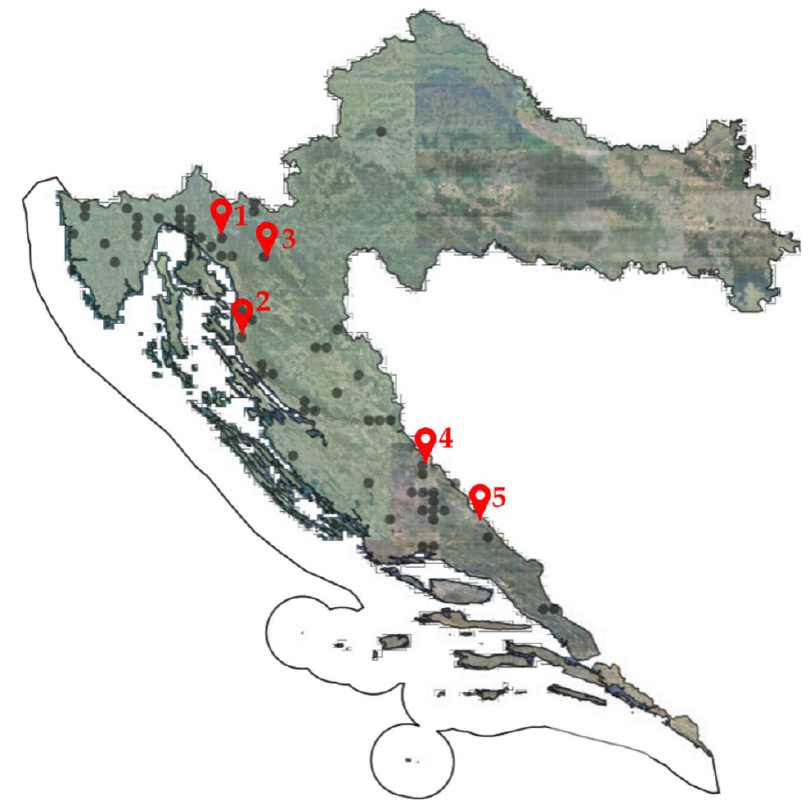
Figure 3. Distribution of Barrelier’s Speedwell in Croatia (black dots) and locations where plant material was collected from for this research (red marks, numbers 1–5 stated in the Table 1). Source for the map with a distribution of the studied species in Croatia: Nikoli´c T. ur. (2015—onwards): Distribution of Pseudolysimachion barrelieri (Schott ex Roem. et Schult.) Holub in Croatia, Flora Croatica Database (http://hirc.botanic.hr/fcd). Faculty of Science, University of Zagreb, accessed on: 10 July 2022. On this basic map authors added red marks of the studied